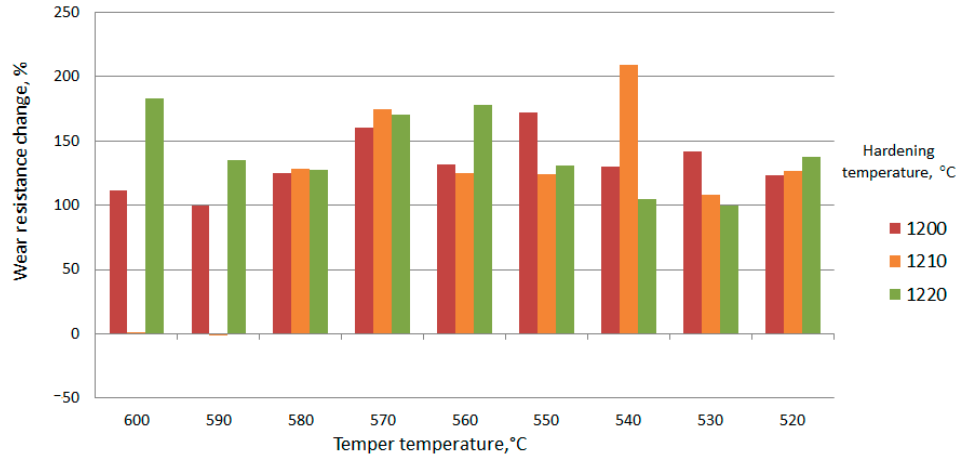
Figure 17. Effect of heat treatment modes on the change in relative wear resistance (%) (W6Mo5Cr4V2 ← TiCN + Ni).